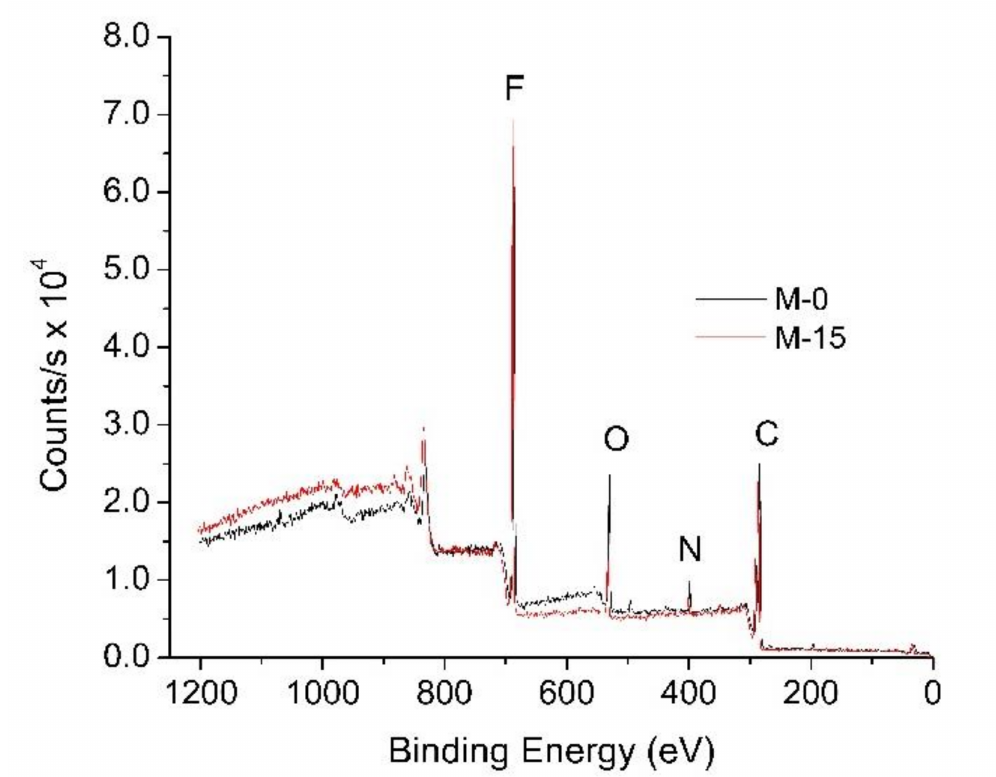
Figure 8. XPS wide scan spectra of M-0 and M-15